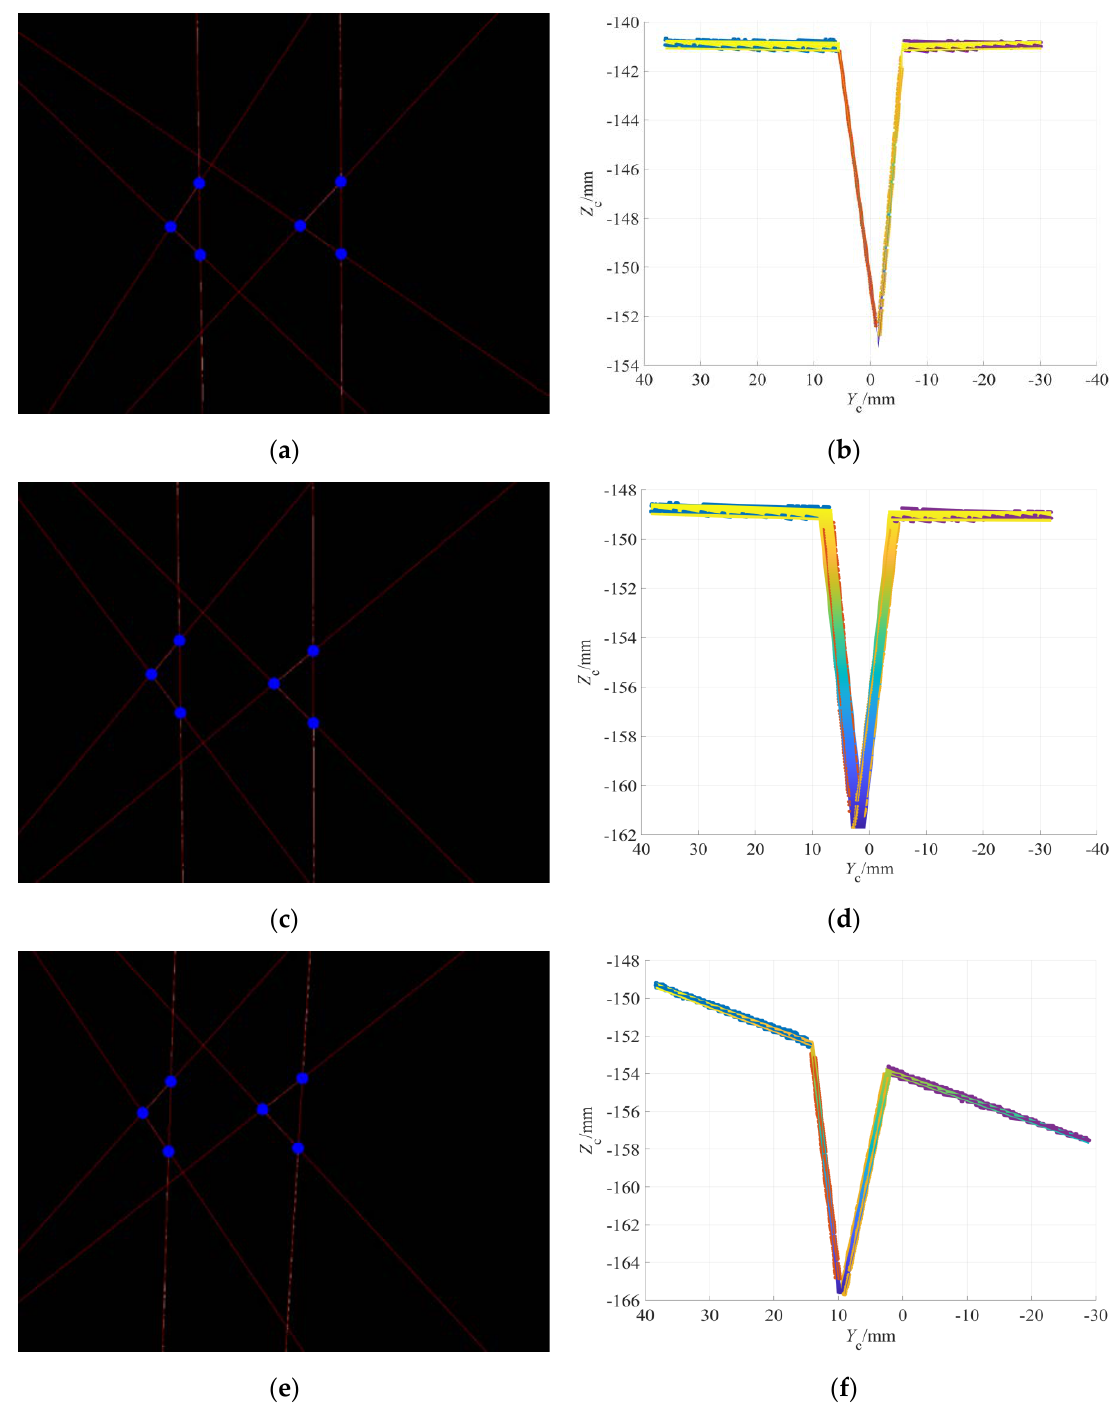
Figure 11. Detection test of welding groove sizes and relative position and posture parameters: ( a ) feature extraction for asymmetric V-groove image, ( b ) 3D reconstruction of asymmetric V-groove surfaces and its adjacent workpiece surfaces, ( c ) feature extraction for V-groove image with position deviation, ( d ) 3D reconstruction of V-groove surfaces and its adjacent workpiece surfaces with position deviation, ( e ) feature extraction for V-groove image with posture deviation and ( f ) 3D reconstruction of V-groove surfaces and its adjacent workpiece surfaces with posture deviation.